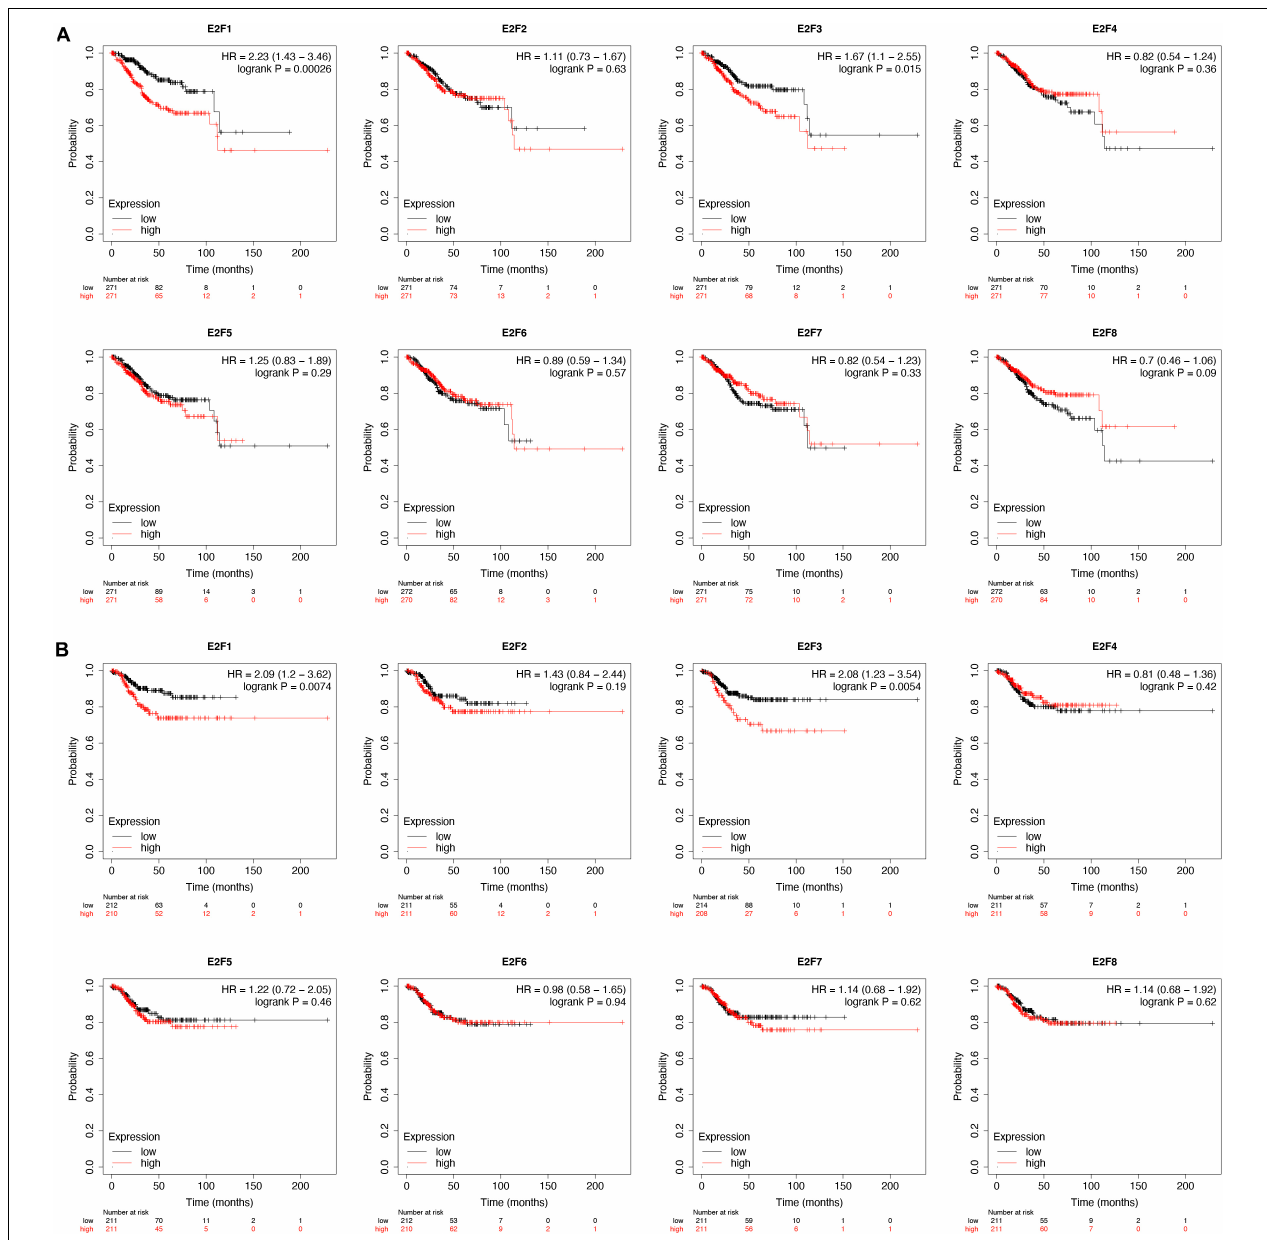
FIGURE 7 | The prognostic value of E2Fs in UCEC. (A) The OS curve for E2Fs in UCEC. (B) The RFS curve for E2F, in UCEC.